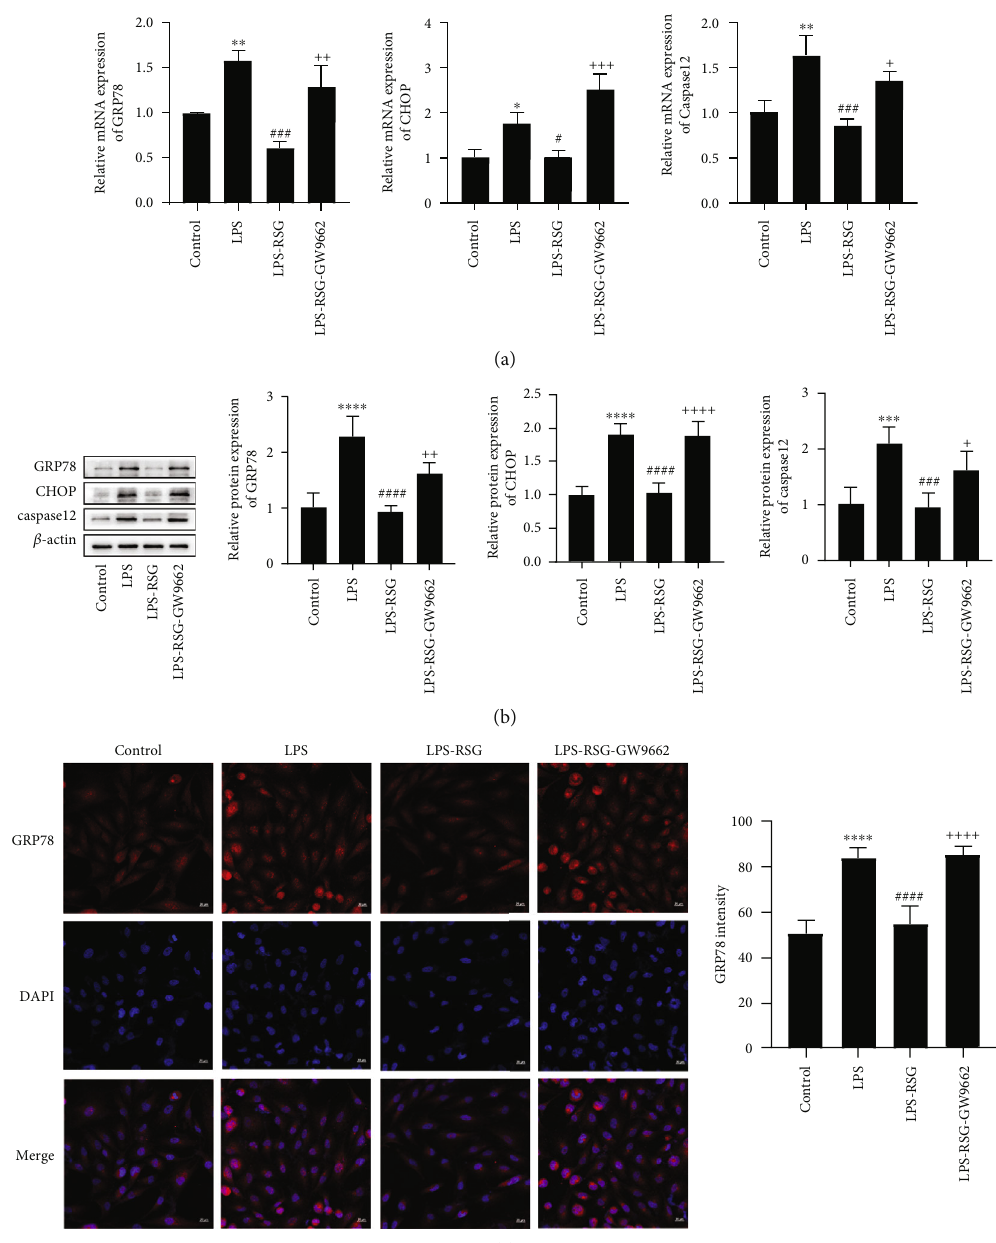
Figure 3: Activation of PPAR γ inhibited LPS-induced ER stress in alveolar epithelial cells. (a) Relative mRNA expressions of GRP78, CHOP, and Caspase12 in A549 epithelial cells. (b) Western blotting and relative protein expressions of GRP78, CHOP, and Caspase12 in A549 epithelial cells. (c) Immuno fl uorescence staining and mean fl uorescence intensity of GRP78 in A549 epithelial cells (original magni fi cation, × 200). Data are presented as mean ± SD . ∗ p < 0 : 05 , ∗∗ p < 0 : 01 , ∗∗∗ p < 0 : 001 , ∗∗∗∗ p < 0 : 0001 vs. Control, # p < 0 : 05 , ### p < 0 : 001 , #### p < 0 : 0001 vs. LPS, + p < 0 : 05 , ++ p < 0 : 01 , +++ p < 0 : 001 , ++++ p < 0 : 0001 vs.